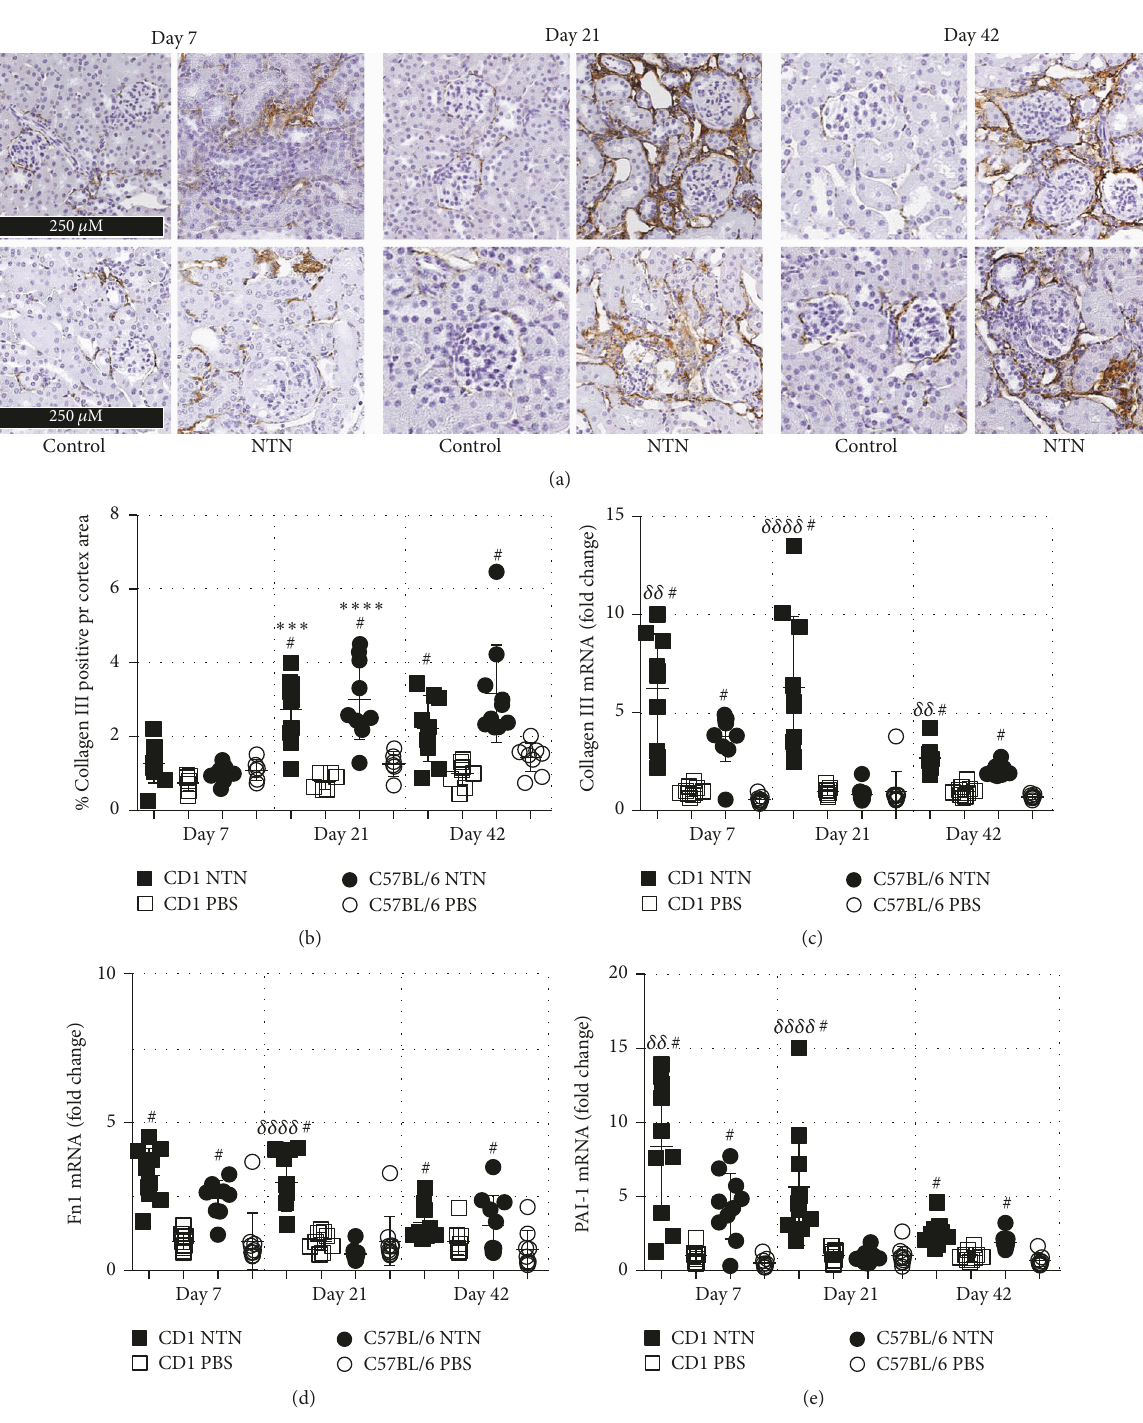
Figure 8: NTS induces chronic renal fibrosis . (a) Representative images of tubulointerstitial fibrotic area visualised by immunohistochemical collagen III staining. (b) Semiquantification of collagen III positive area of the cortex area. (c) Scatter plot showing mRNA expression in whole kidney tissue of Col3a1 as fold change. (d) Fibronectin (Fn1) mRNA expression as fold change. (e) PAI-1 (Serpine-1) mRNA expression as fold change. Data are shown as mean ± SD. # 𝑃 < 0.0001 NTN groups versus PBS groups; ∗∗∗ 𝑃 < 0.001 NTN day 7 versus NTN day 21; ∗∗∗∗ 𝑃 < 0.0001 NTN day 7 versus NTN day 21; and 𝛿𝛿 𝑃 < 0.01 , 𝛿𝛿𝛿𝛿 𝑃 < 0.0001 CD1 NTN versus B6 NTN groups by two-way ANOVA ( 𝑛 = 10